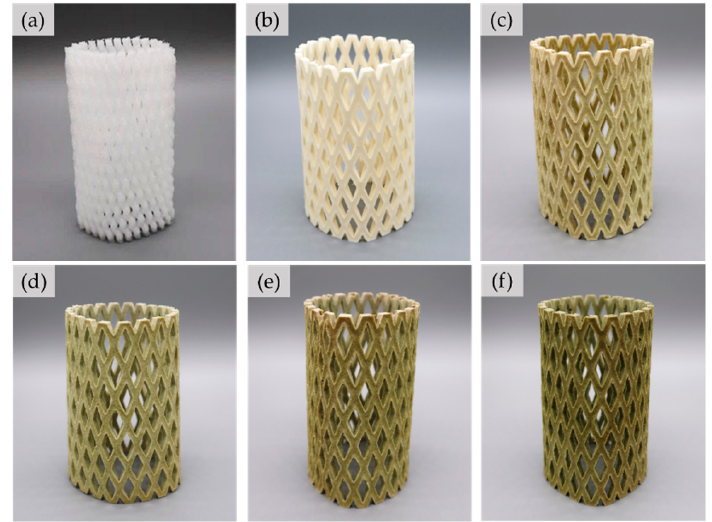
Figure 5. Cushion foam net: ( a ) EPE-FN; ( b ) NRL-FN-BLF0.0; ( c ) NRL-FN-BLF2.5; ( d ) NRL-FN- BLF5.0; ( e ) NRL-FN-BLF7.5; ( f )